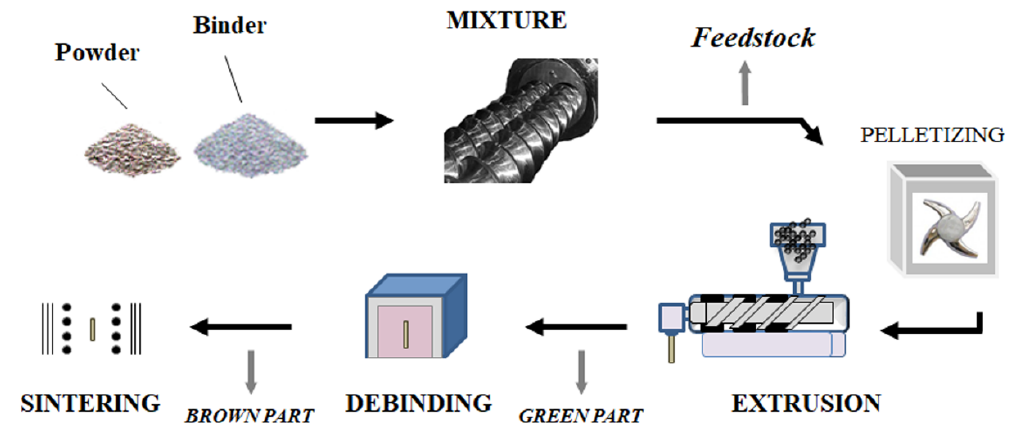
Figure 8. Fabrication process based on extrusion used by Sotomayor et al. Reprinted with permission of Journal of Power Sources 437, 2019, 226923 [86].